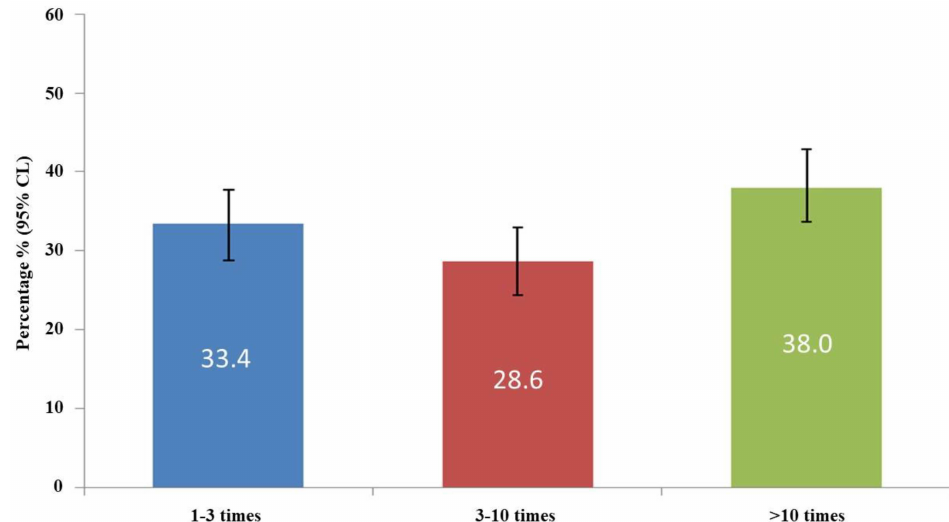
Figure 1. Frequency of blood